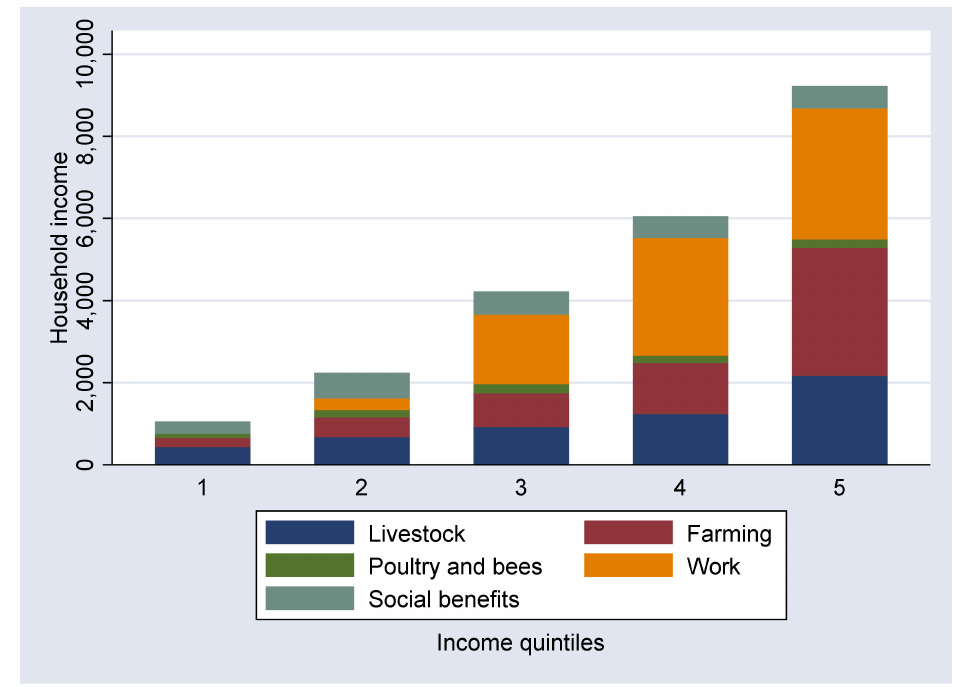
Figure 4. Income quintiles of the surveyed households (N =